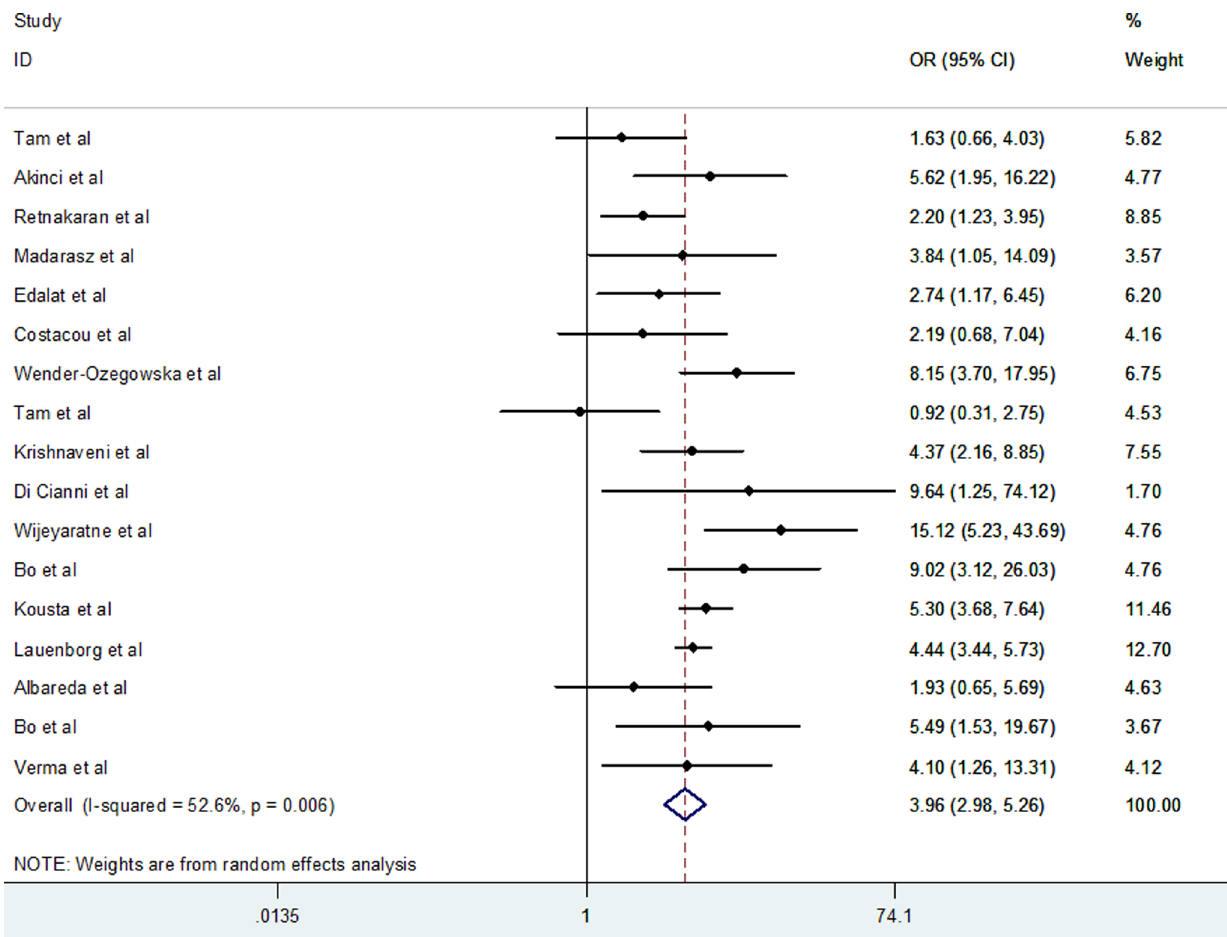
Figure 2. Forest plot of overall risk of metabolic syndrome (MS) after gestational diabetes mellitus (GDM).